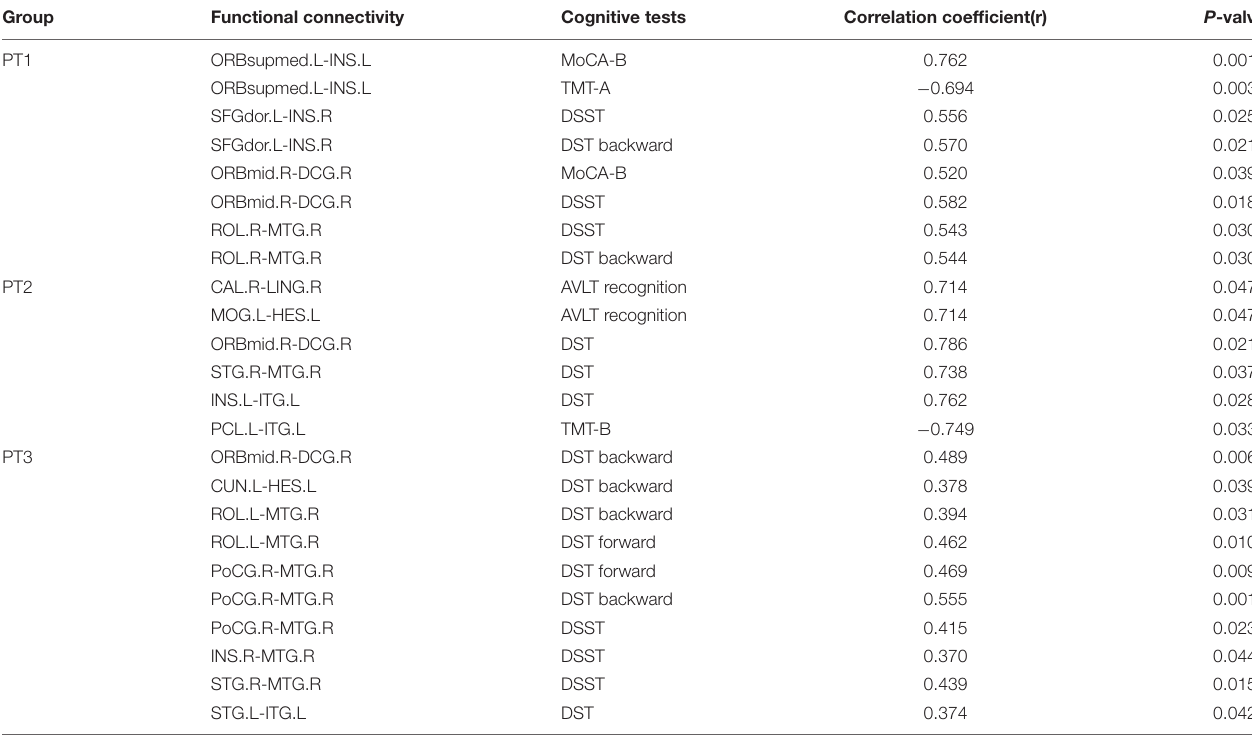
TABLE 3 | Correlations between reduced functional connectivity and cognitive function in NPC patients (before multiple comparisons). Group Functional connectivity Cognitive tests Correlation